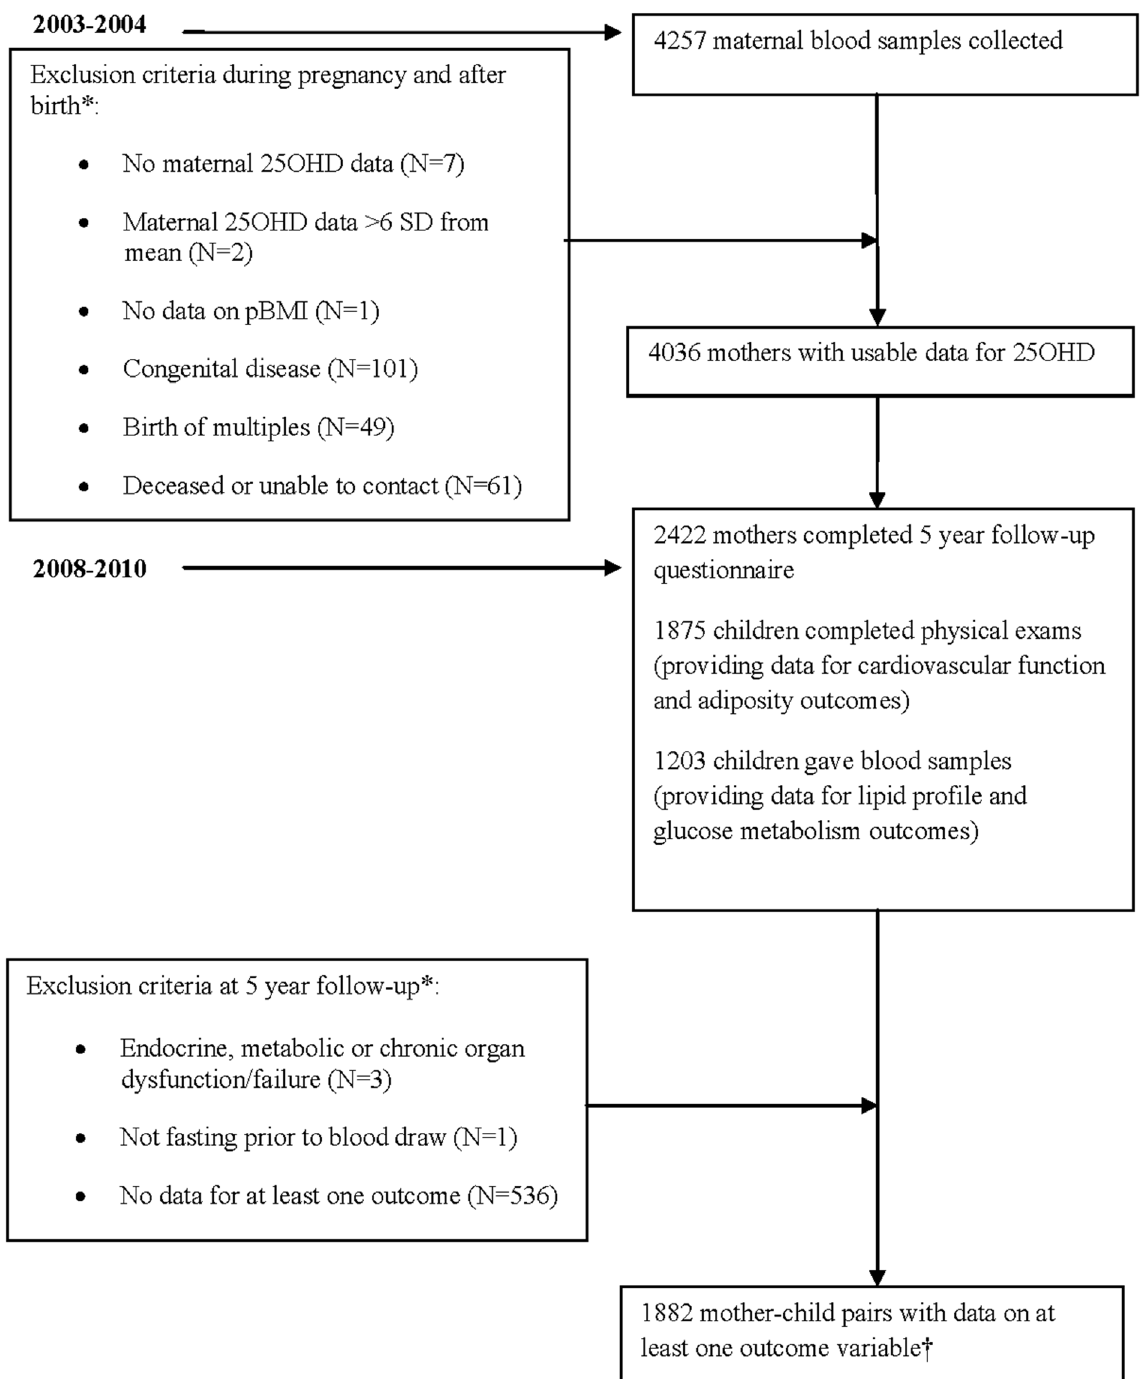
Fig 1. Flow chart of study participants. Selection of study sample from data collected for the Amsterdam Born Children and their Development cohort study. 25OHD = 25-hydroxyvitamin D, pBMI = pre-pregnancy BMI, SD = standard deviation. * Note: Exclusion criteria overlap in some participants. † Note: In the final study sample, some children completed only the physical exam and some only provided blood samples. As a result the final sample size is greater than the number of children measured in just the physical exam or just the blood testing component.